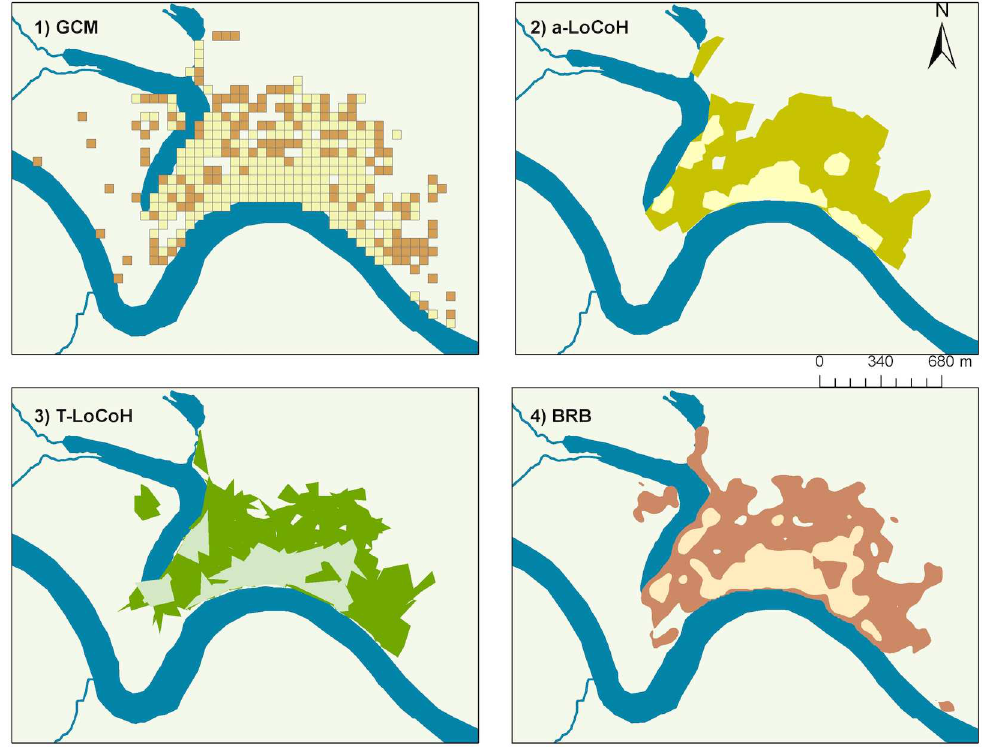
Fig 5. An example of the home range estimatesproduced for one proboscis monkey. Home range estimator (1) Grid-cellmethod (GCM), (2) adaptivelocal convex hull ( a -LoCoH), (3) adaptive time local convex hull (T-LoCoH), and (4) biasedrandom bridges(BRB); light colours = 50% isopleth,and dark colours= 90% isopleth.